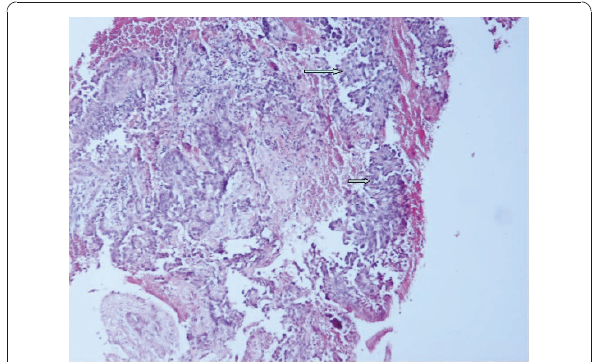
Figure 3 Bronchoscopy biopsy . Low differentiated adenocarcinoma with micropapillary component (arrow). (Hematoxylin-eosin, ×100).